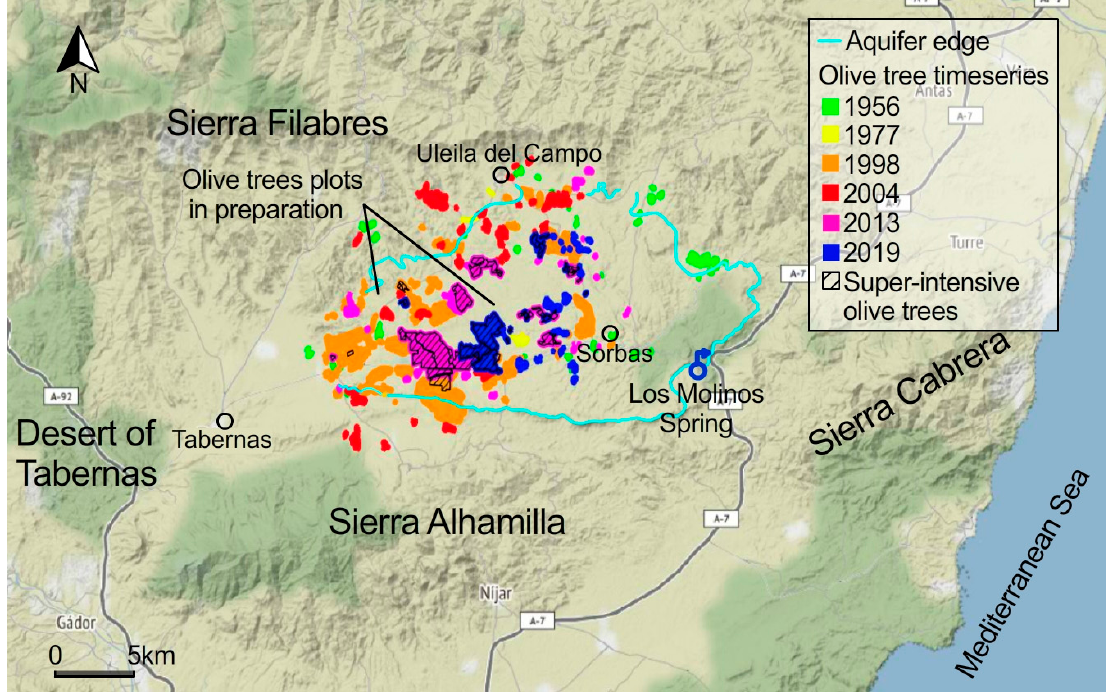
Figure 3. Temporal and spatial evolution of the olive grove surface in 1956, 1977, 1998, 2004, 2013,